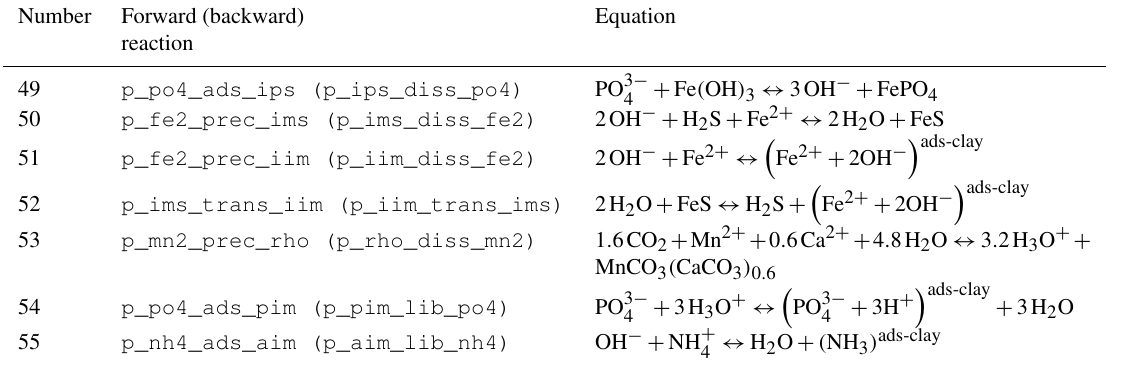
Table 5. Reaction network table for adsorption–desorption and precipitation–dissolution processes in the sediment and in the fluff layer. Number